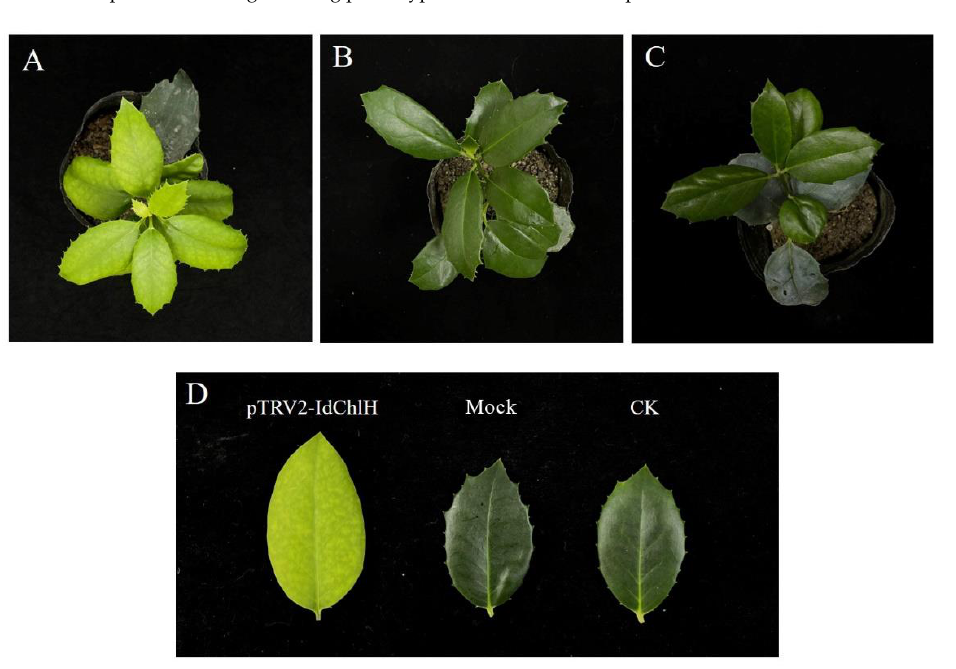
Figure 5. TRV-mediated IdChlH gene silencing in I. dabieshanensis . ( A ) I. dabieshanensis plants infected with pTRV2- IdChlH exhibiting yellow-leaf phenotype in newly developed leaves at 21 days post infiltration (dpi). ( B ) Empty vector-infected plants (Mock) with the normal phenotype. ( C ) Control plants (CK). ( D ) Leaf phenotypes after various VIGS treatments. Photographs were taken at 21 dpi.